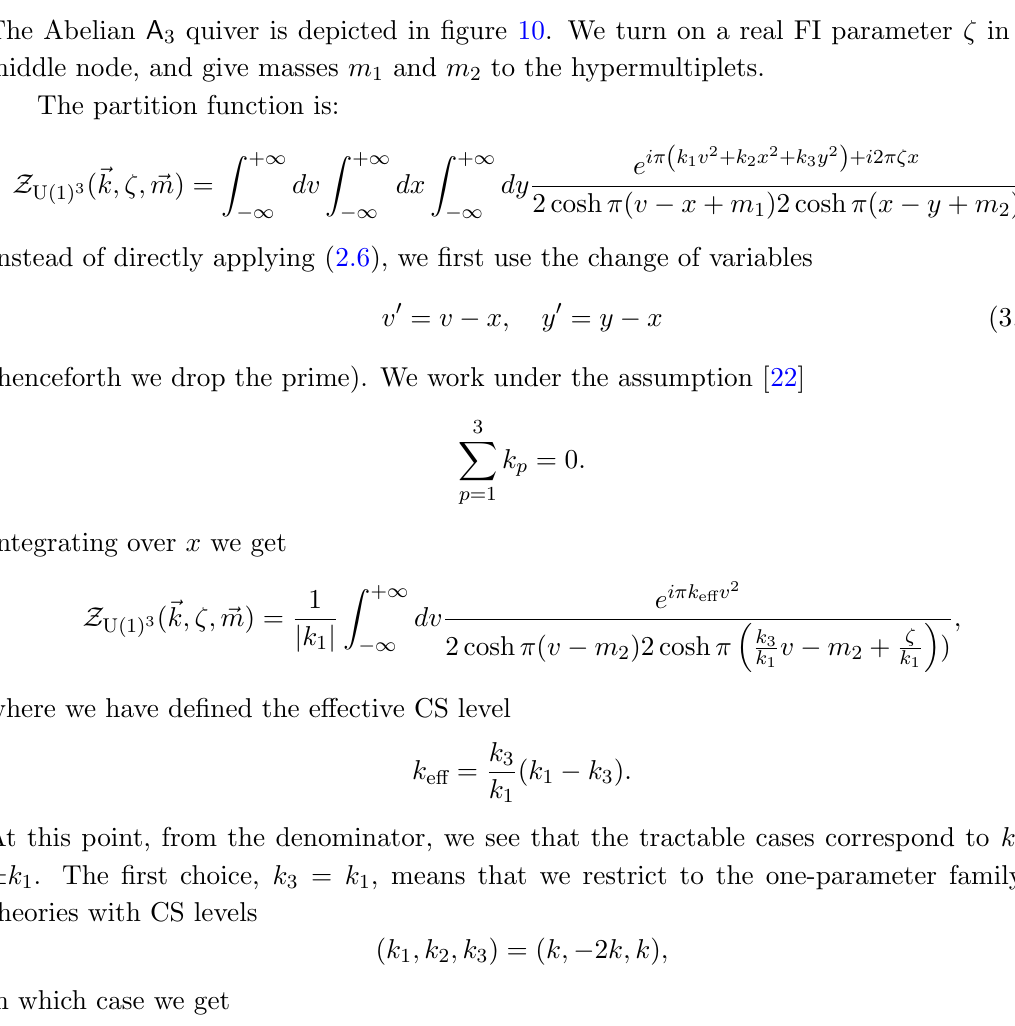
Figure 10 . Abelian A 3